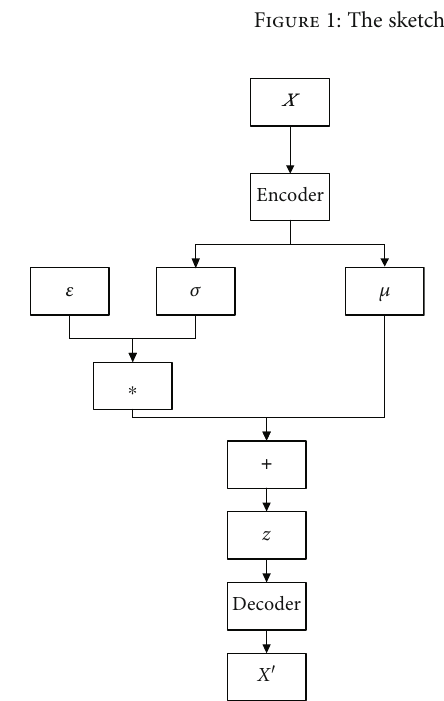
Figure 2: A typical VAE structural